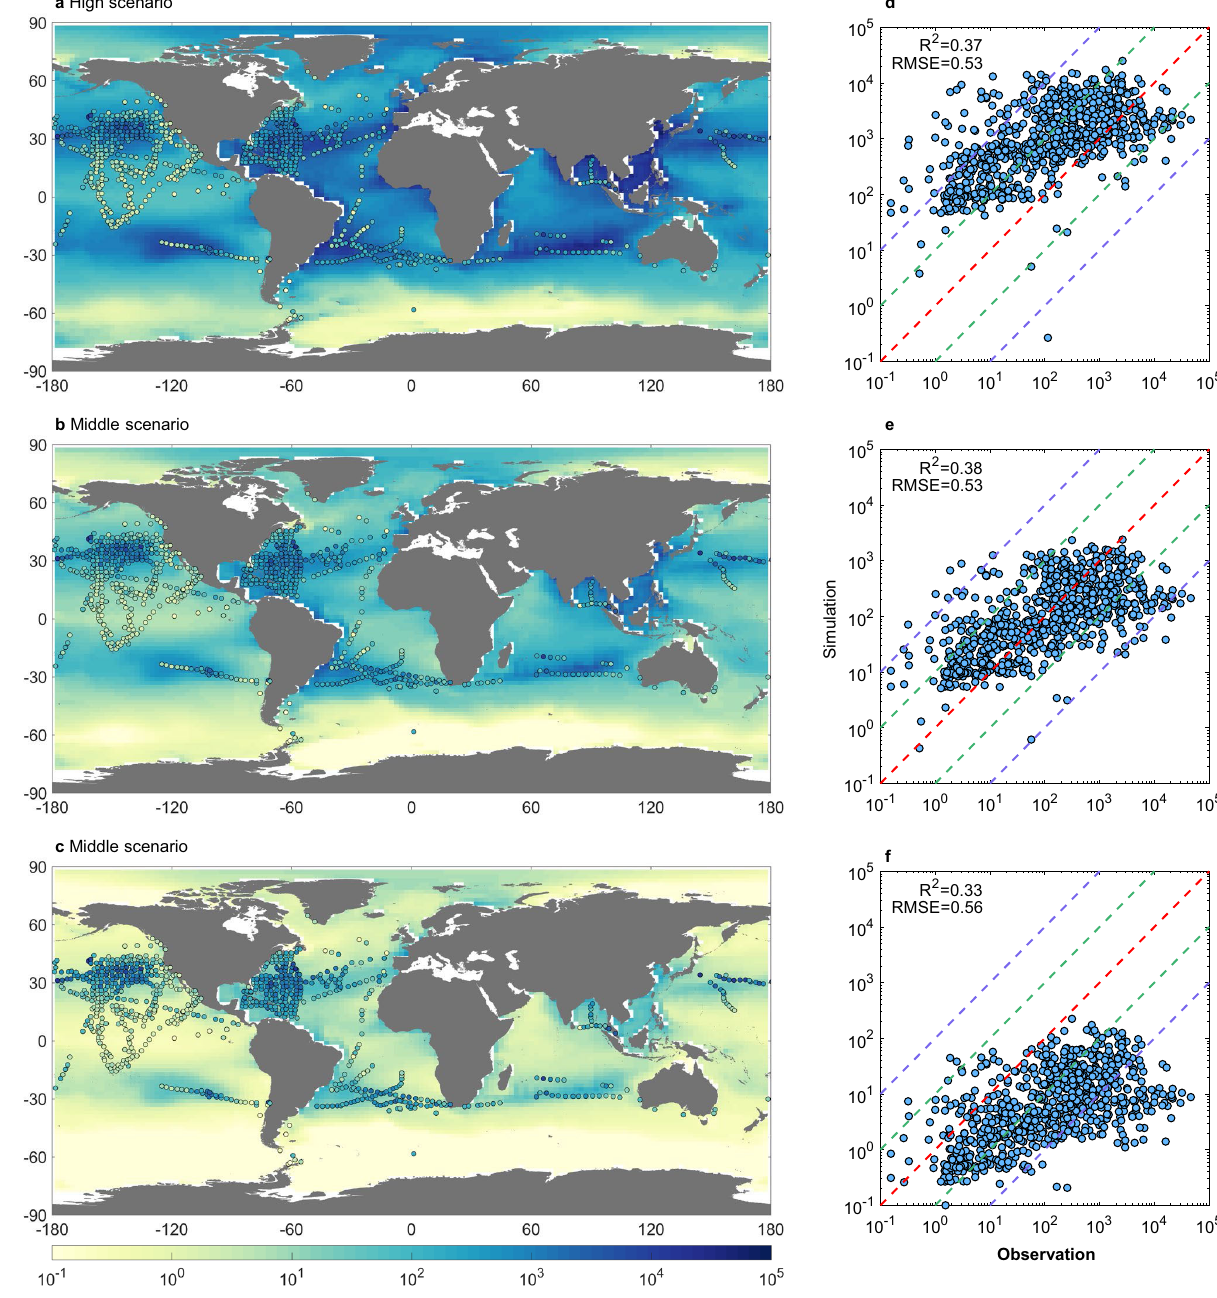
Fig. 2 | Comparison between the modeled and observed total surface ocean plastic mass concentrations. a , d High emission scenario. b , e Middle emission scenario. c , f Low emission scenario. In panels a – c , the background colors are the modeled annual mean for the year 2018, while the circles are observations. In